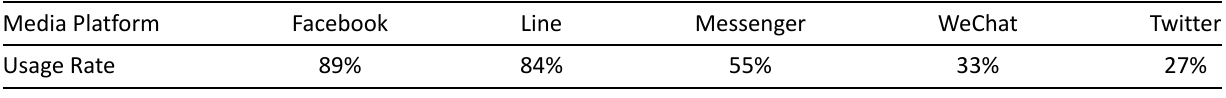
Table 1. Social media platform usage in Taiwan. Media